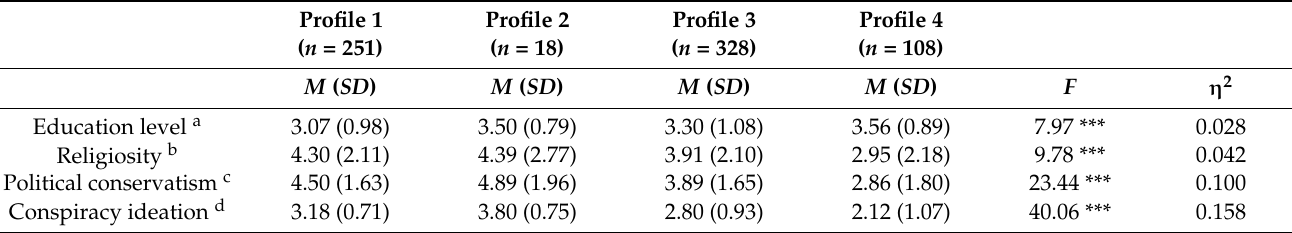
Table 5. Differences between profiles: other